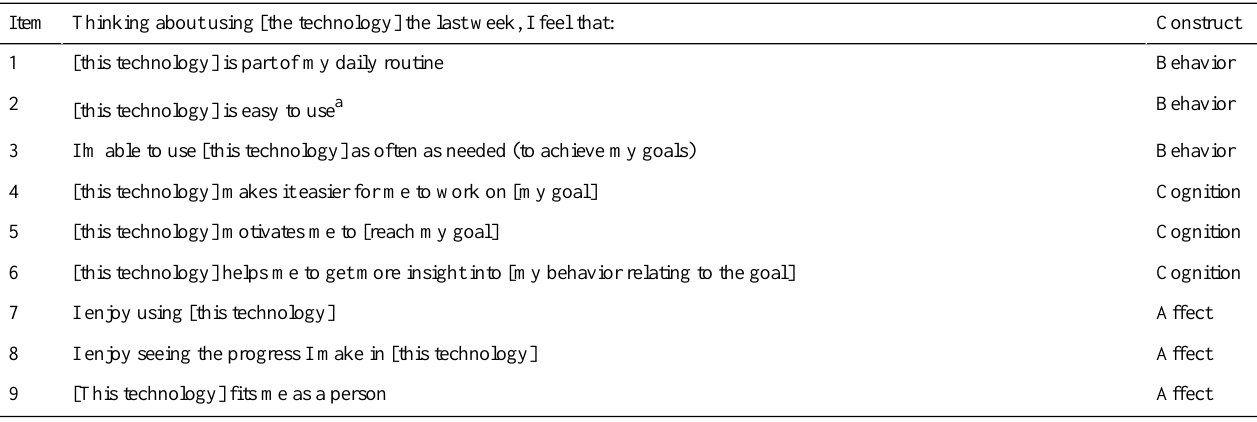
Table 1. The Twente Engagement with Ehealth Technologies Scale